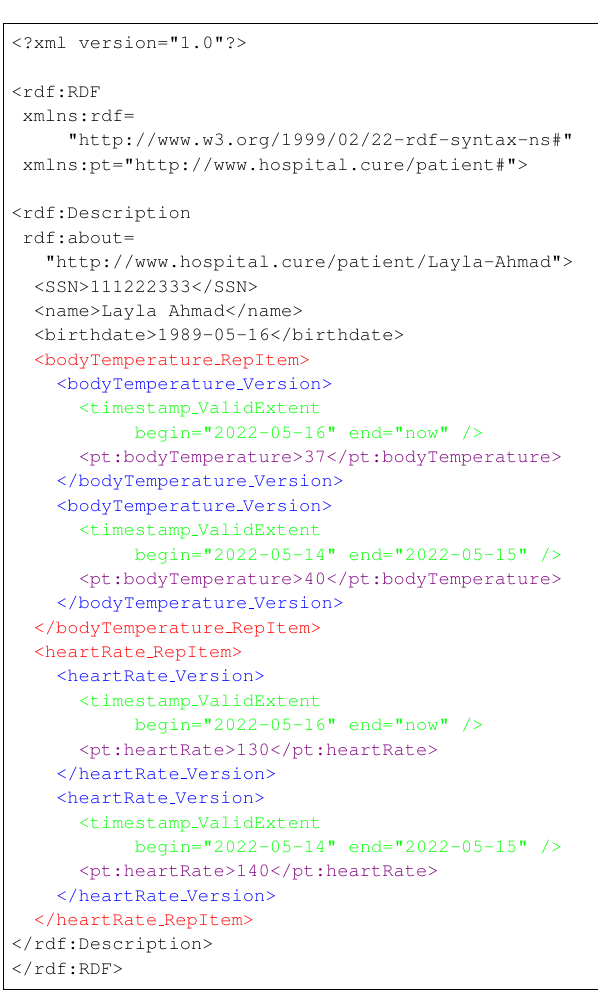
Fig. 1 An example of a temporal ontology